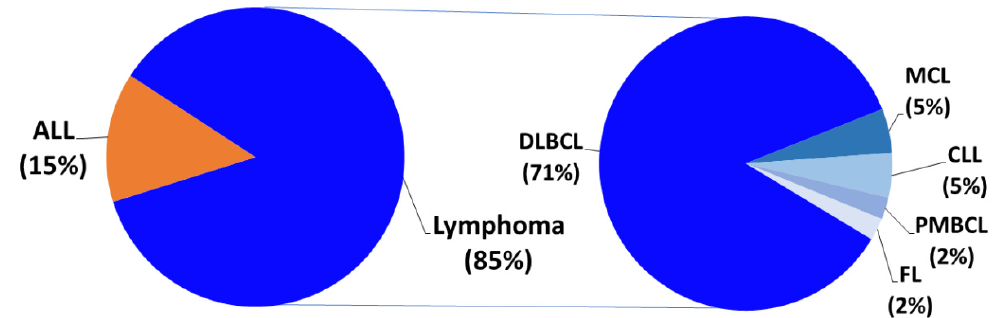
Figure 1. Distribution of patients undergoing leukapheresis by disease. The main share of patients had been diagnosed with lymphoma (85%), shown separately by subgroup: diffuse large B-cell lymphoma (DLBCL, 71%), mantle cell lymphoma (MCL, 5%), follicular lymphoma (FL, 2%), primary mediastinal B-cell lymphoma (PMBCL, 2%), or chronic lymphocytic leukemia (CLL, 5%). The other studied entity is the acute lymphoblastic leukemia (ALL, 15%).